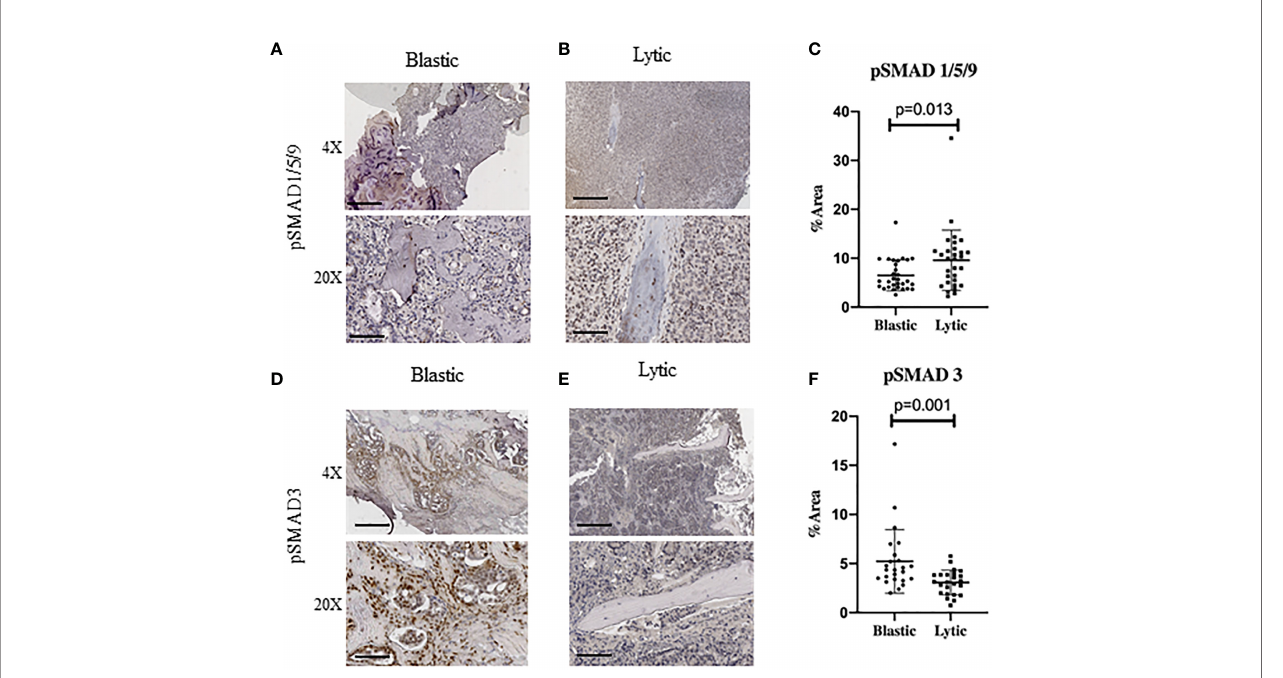
FIGURE 1 | Human Metastatic Prostate Cancer in Bone Express Distinct TGF b and BMP Signaling. Canonical BMP signaling can be detected by the nuclear translocation of BMP speci fi c SMAD1/5/9 whereas canonical TGF b signaling can be detected by nuclear translocation of SMAD3, which are both active when phosphorylated. (A) Blastic bone pathology from human patients with metastatic prostate cancer at low power (above) and high power (below) stained for pSMAD1/ 5/9 by IHC. (B) Lytic bone pathology from human patients with metastatic prostate cancer at low power (above) and high power (below) stained for pSMAD1/5/9 by IHC. (C) Quanti fi cation of DAB positive IHC staining by total percent area is graphed for at least fi ve distinct fi elds of view for no less than 6 patients per group and analyzed for signi fi cance by Mann-Whitney U test and error bars indicate SD. (D – F) Blastic and lytic samples IHC stained for pSMAD3 and compared for expression between blastic and lytic pathology. Scale bars for 4X and 20X are 200µm and 50µm